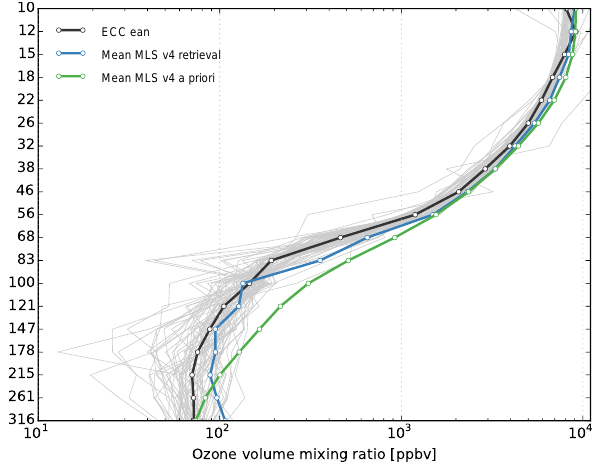
Figure 16. Vertical profiles of ozone mixing ratio from ECC profiles convolved to MLS pressure levels (mean in dark grey; individual profiles in light grey), MLS v4 retrievals in the validation domain (blue) and MLS v4 a priori profiles in the validation domain